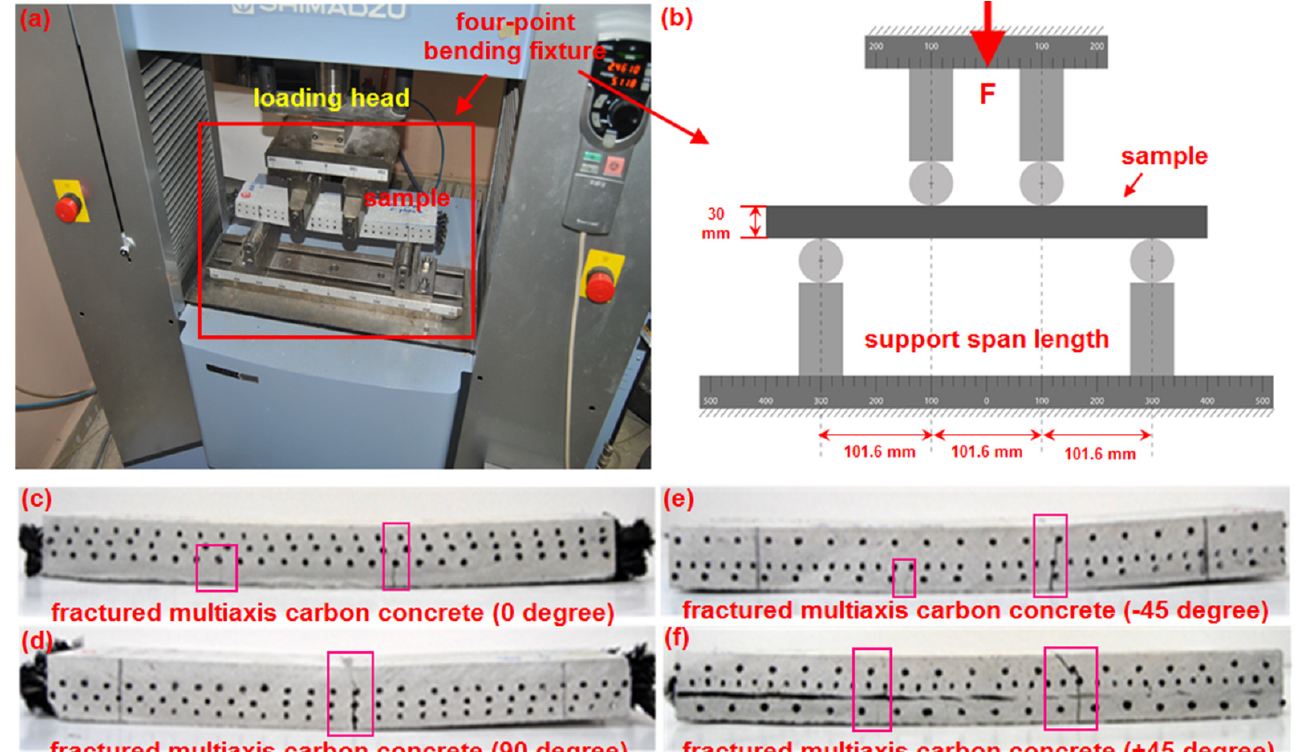
Figure 4. Multiaxis 3D carbon concretes during the flexural test. ( a ) Pictorial view of the flexural test of sample in the universal testing machine; ( b ) specimens with a four-point flexural test fixture, schematic; ( c ) fractured carbon concrete, C-4D-(0°); ( d ) C-4D-(90°); ( e ) C-4D-(+45°), and ( f ) C-4D-( − 45°) (digital image).